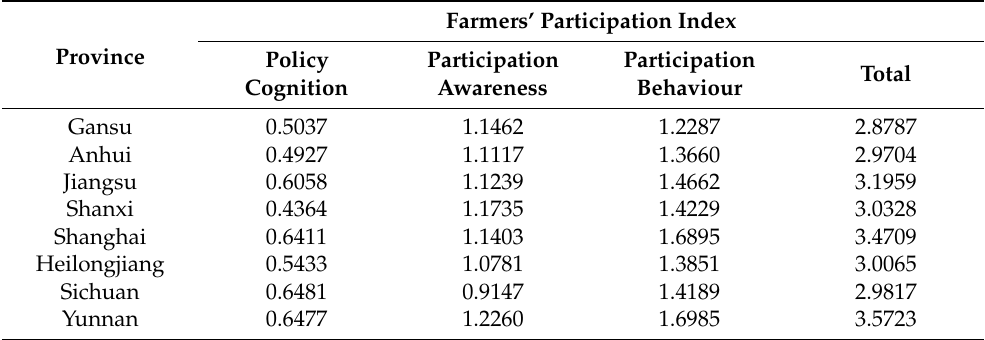
Table 6. Farmers’ participation index in rural settlement environment improvement.